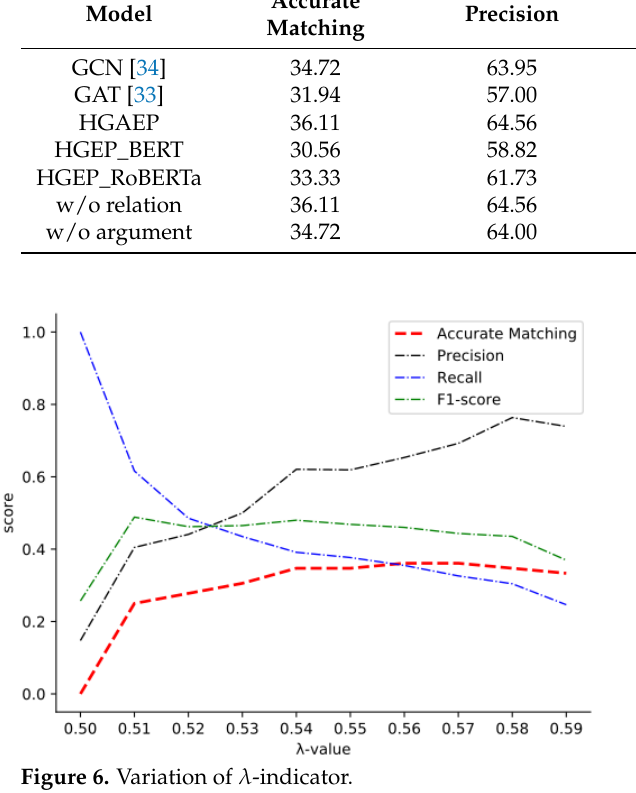
Figure 6. Variation of λ -indicator.